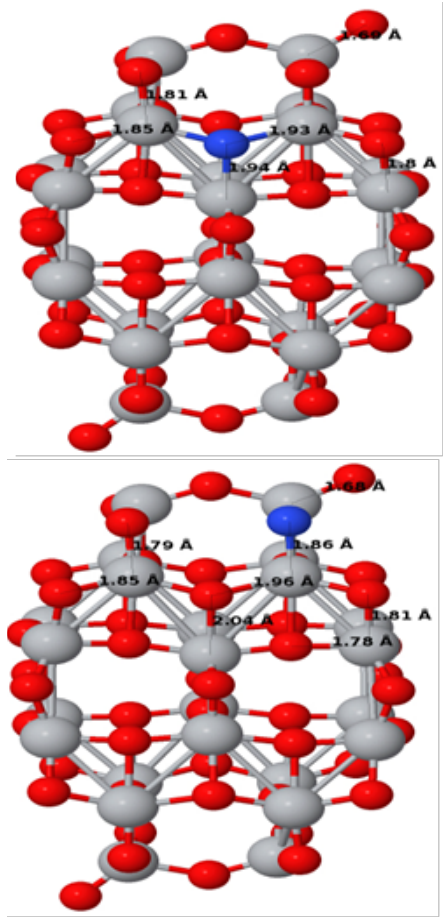
Fig. 3. Optimized geometry structures of two types of N-doped TiO anatase nanoparticles corresponding to two doping 2 configurations. The larger gray spheres are Ti atoms and the small red and blue ones represent O and N atoms, respectively.